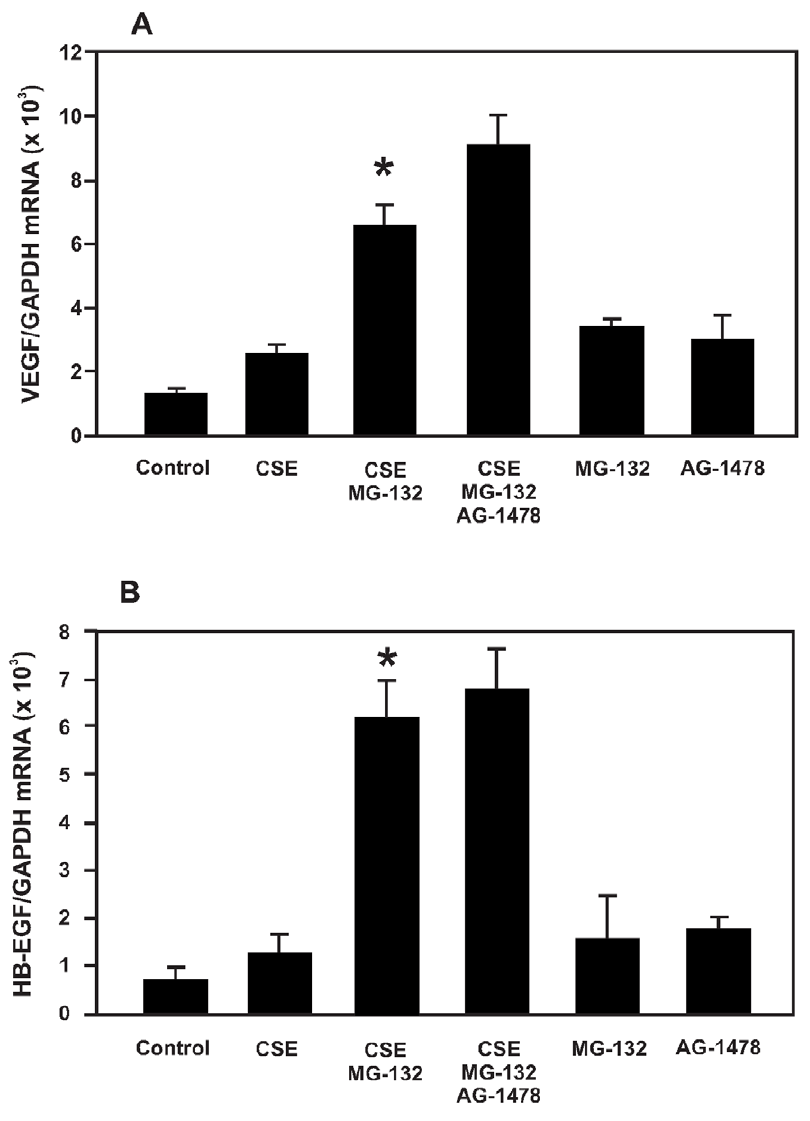
Figure 6. Effects of CSE and proteasome inhibition on VEGF and HB-EGF mRNA expression. Cells were pre-treated with inhibitor(s) for 30 min, and then with 10% CSE for another 5 h. DMSO was used as a vehicle control. A: VEGF mRNA expression levels in B6Tert-1 cells treated with different agents in FD medium. B: HB-EGF mRNA expression levels in B6Tert-1 cells treated with different agents in FD medium. CSE: 10% cigarette smoke extract; MG-132: proteasome inhibitor at 5 m M; AG-1478: EGFR kinase inhibitor at 5 m M. The asterisk (*) indicates a statistically significant difference ( p , 0.05) when compared with CSE-treated cells.